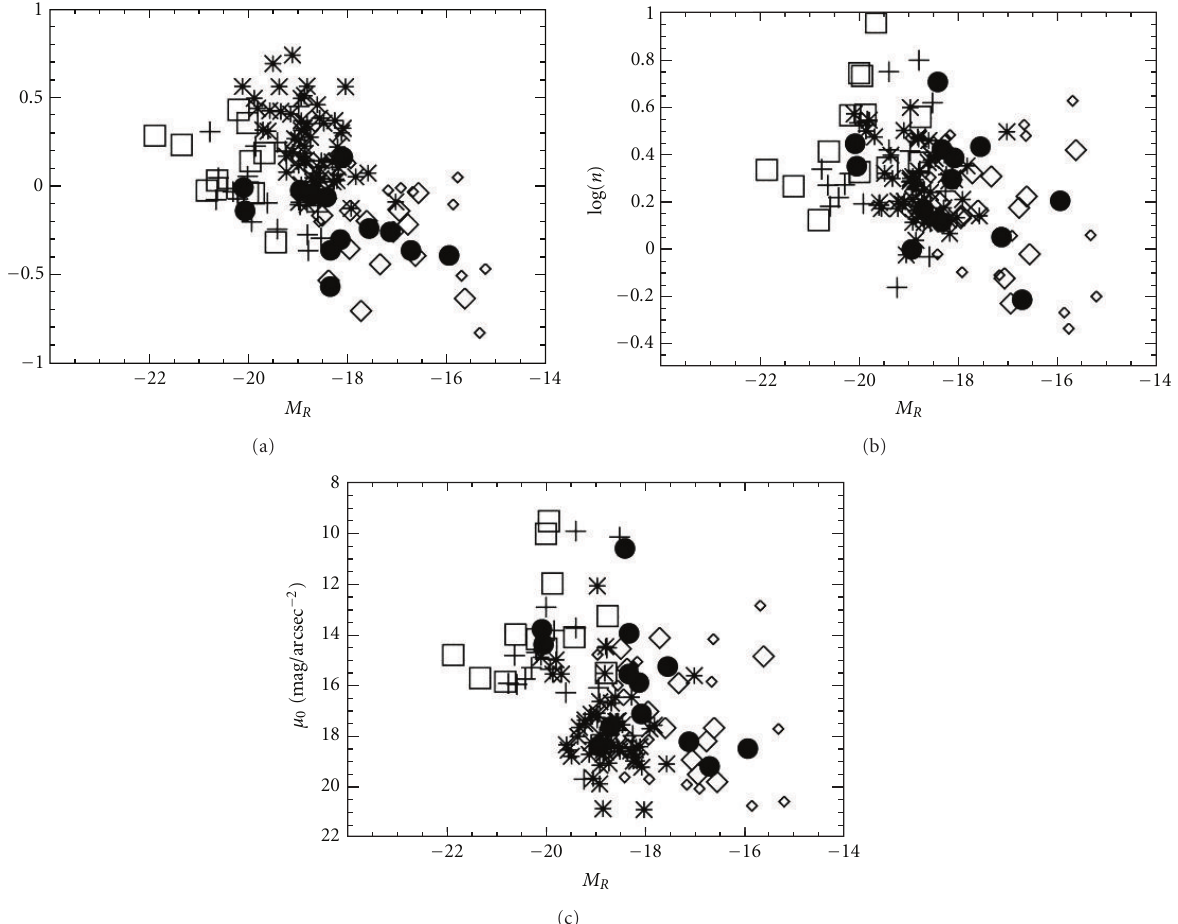
Figure 16: E ff ective radius (a), S´ersic shape parameter (b), and central surface brightness (c) as functions of the R-band absolute magnitude of dE (asterisks) and bulges of dS0 (diamonds), late-type spirals (circles), early-type spirals (crosses), and S0 galaxies (squares) in the Coma cluster. See for more details